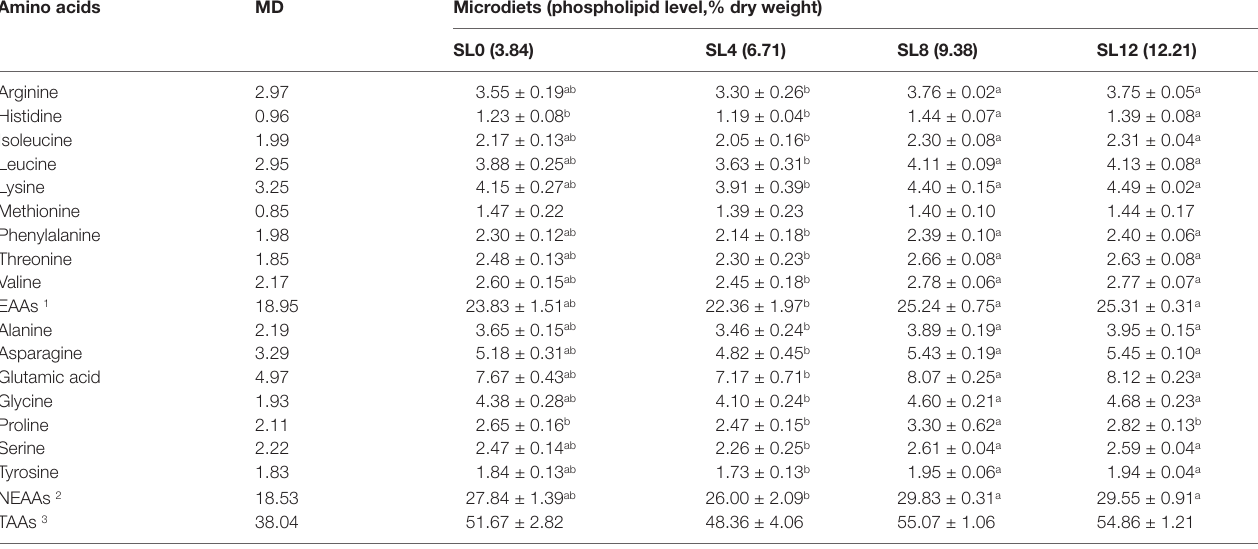
TABLE 6 | Amino acid composition of the MD and 55-dph rock bream larvae (mg/g, dry matter). Amino acids